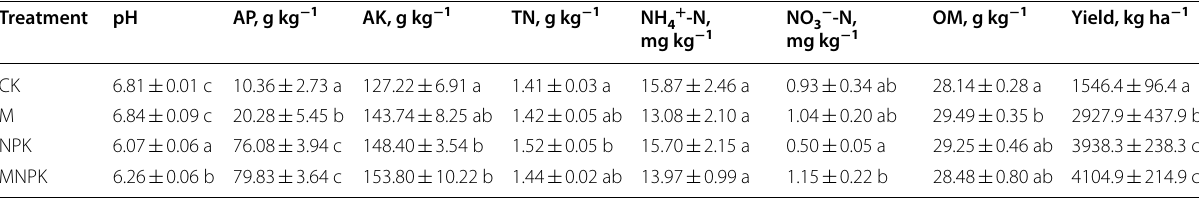
Values are means standard deviations (n 3). Values within the same column followed by different letters indicate significant differences ( P < 0.05) according to ± = Tukey’s multiple comparison Treatment: CK, no fertilizer; M, manure; NPK, chemical nitrogen, phosphorus and potassium fertilizer; MNPK, chemical nitrogen, phosphorus and potassium fertilizer plus manure Soil properties: AP, available P; AK, available K; TN, total nitrogen; NH 4 + , ammonium nitrogen; NO 3 − -N, nitrate nitrogen; OM, organic matter